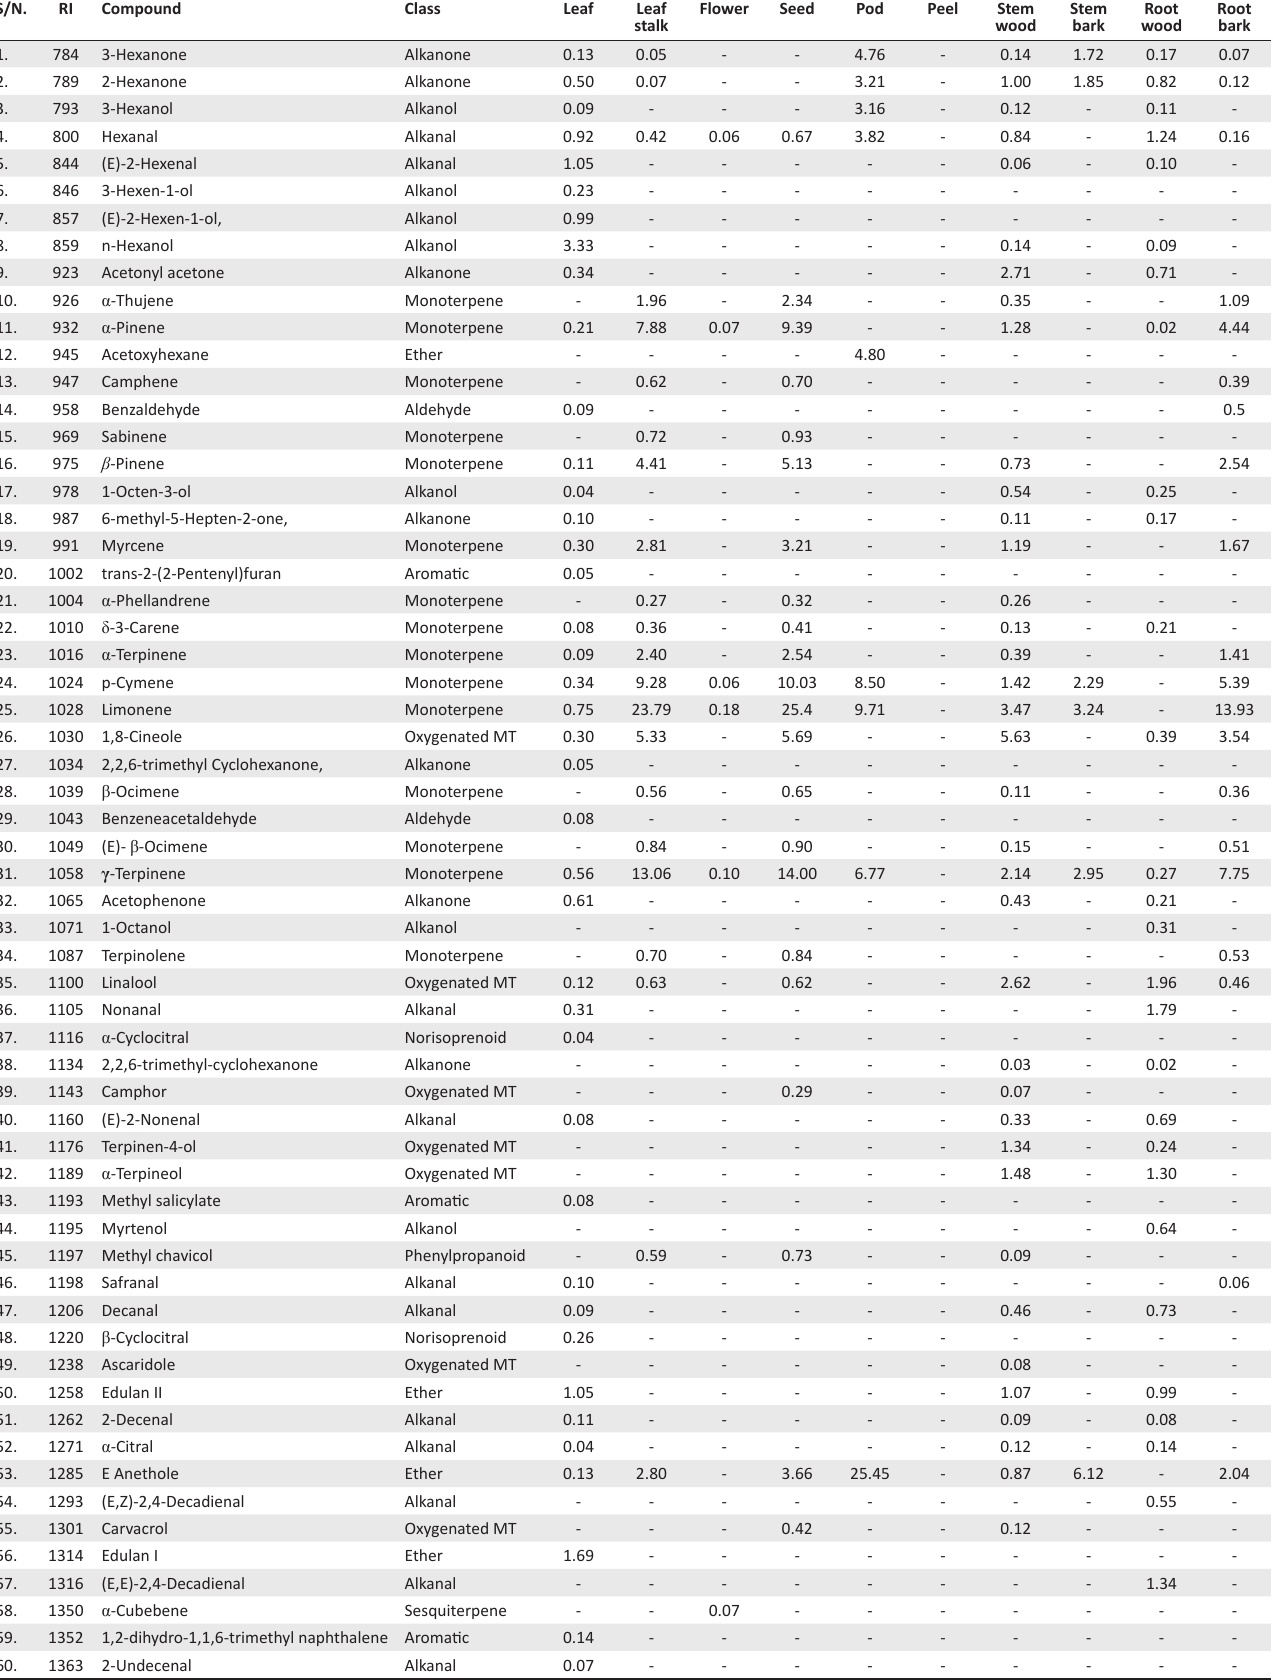
TABLE 2a: Chemical constitution of 10 essential oils from Calophyllum inophyllum Linn.